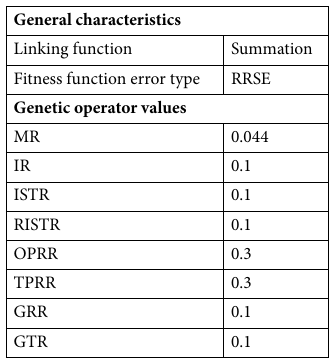
Table 3. The GEP model